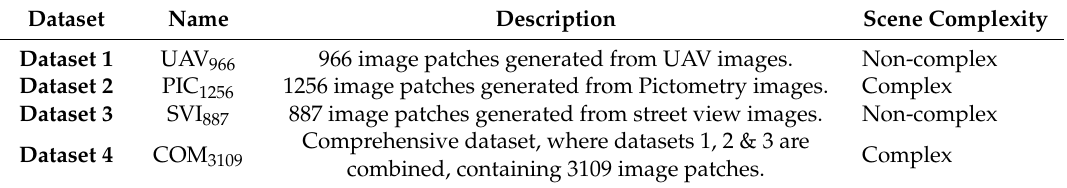
Table 7. Naming of datasets based on the image characteristics and number of